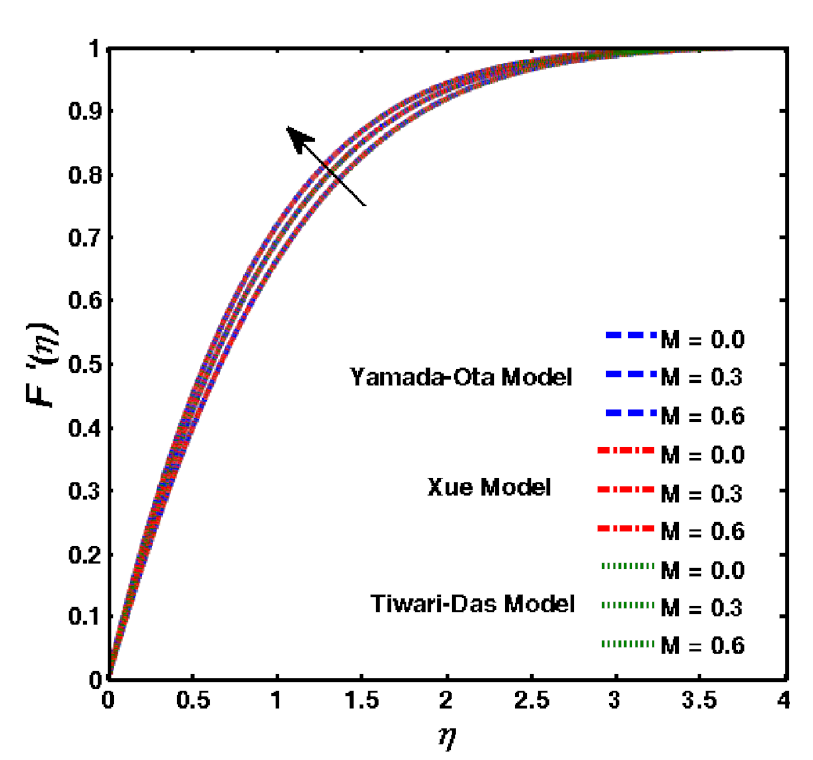
Figure 4. Influence of φ 2 on F (cid:48) ( η ) .